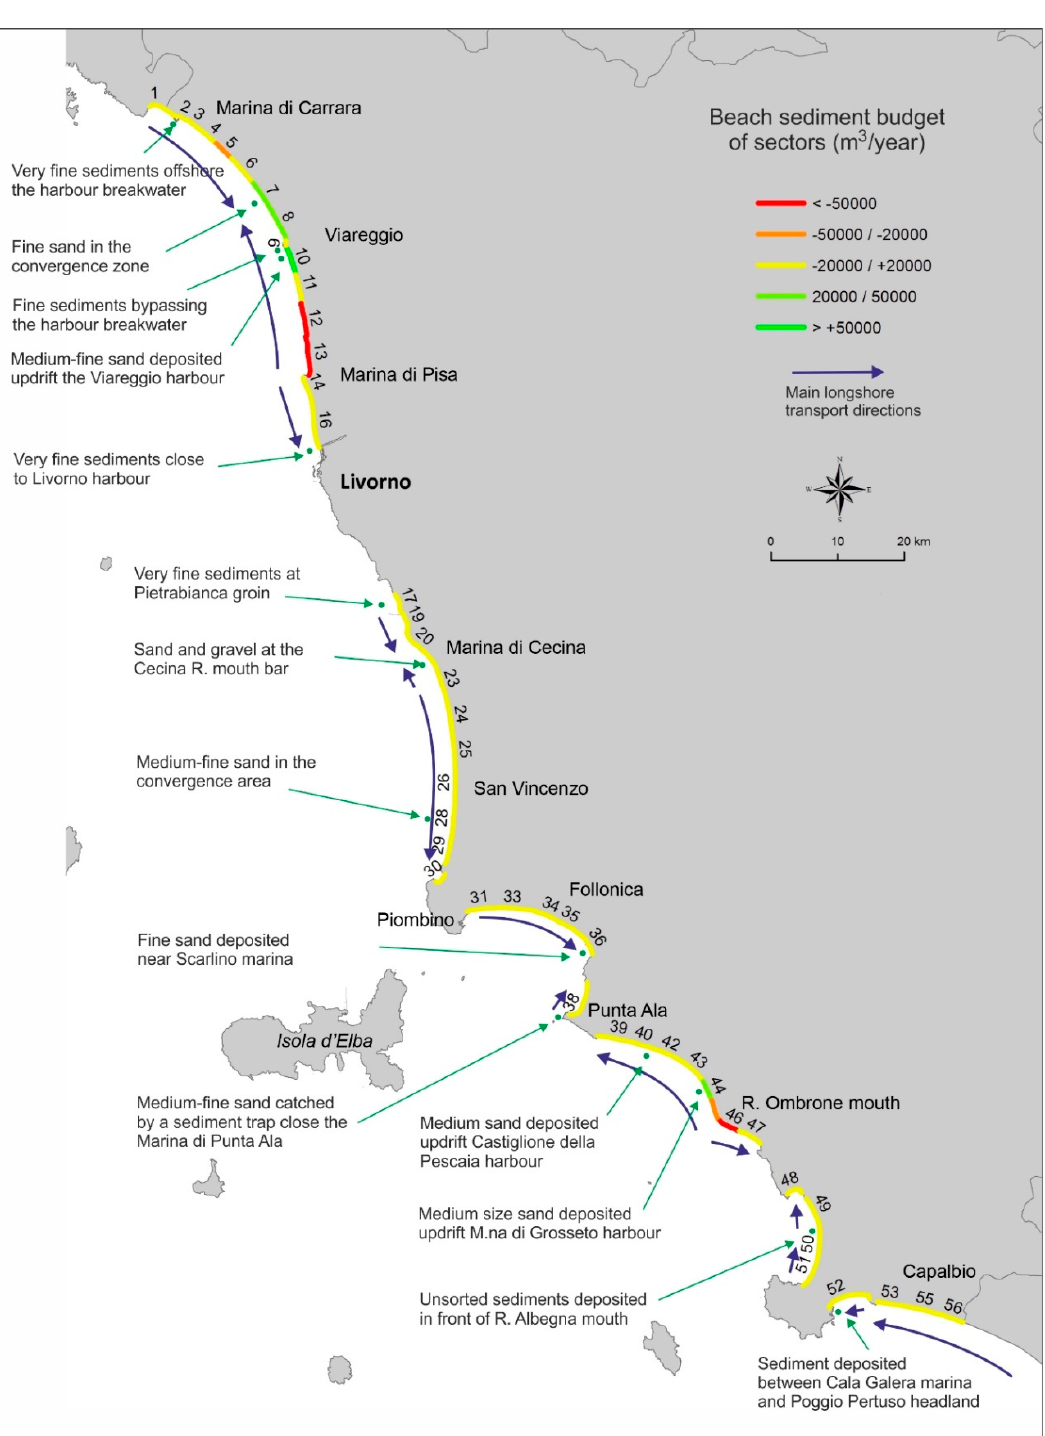
Figure 4. Potential dry beach and shoreface borrow sites for beach nourishment.